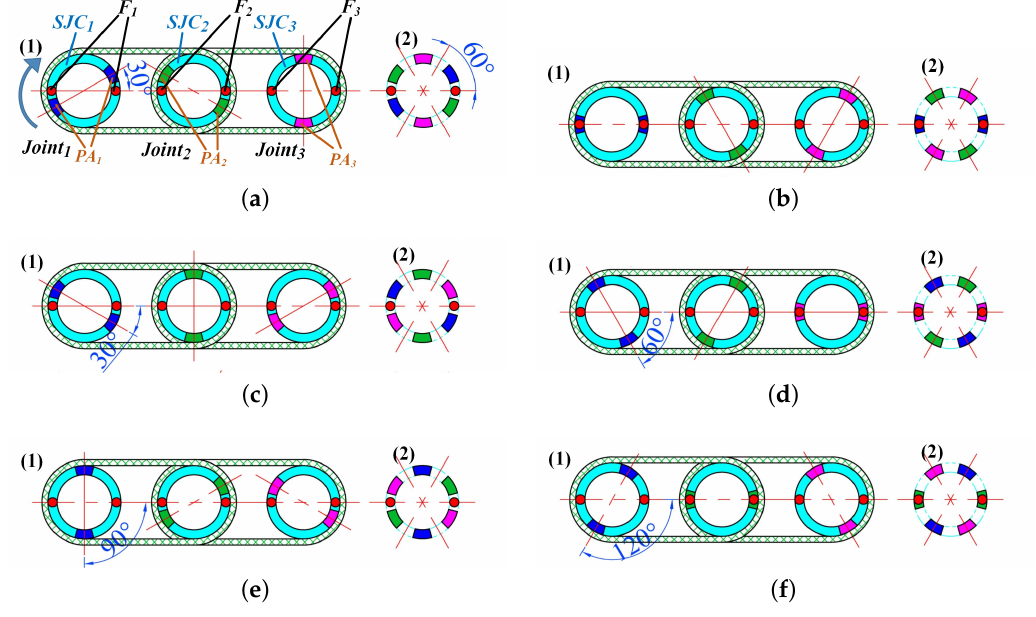
Figure 13. The phase relations of work areas of 3 cams which are driven to rotate clockwise by the switch motor. PA 1 – PA 3 are cam work areas of SJC 1 – SJC 3 . F 1 – F 2 are the contact points between the SJC and SJF of Joint 1 – Joint 3 . The right sub-sub-figure of every sub-figure is the current phase of cams’ work areas. ( a ) The initial status of SJC 1 – SJC 3 . ( b ) SJC 1 – SJC 3 rotate 30 deg synchronously relative to ( a ). ( c ) SJC 1 – SJC 3 rotate 30 deg synchronously relative to ( b ). ( d ) SJC 1 – SJC 3 rotate 30 deg synchronously relative to ( c ). ( e ) SJC 1 – SJC 3 rotate 30 deg synchronously relative to ( d ). ( f ) SJC 1 – SJC 3 rotate 30 deg synchronously relative to ( e